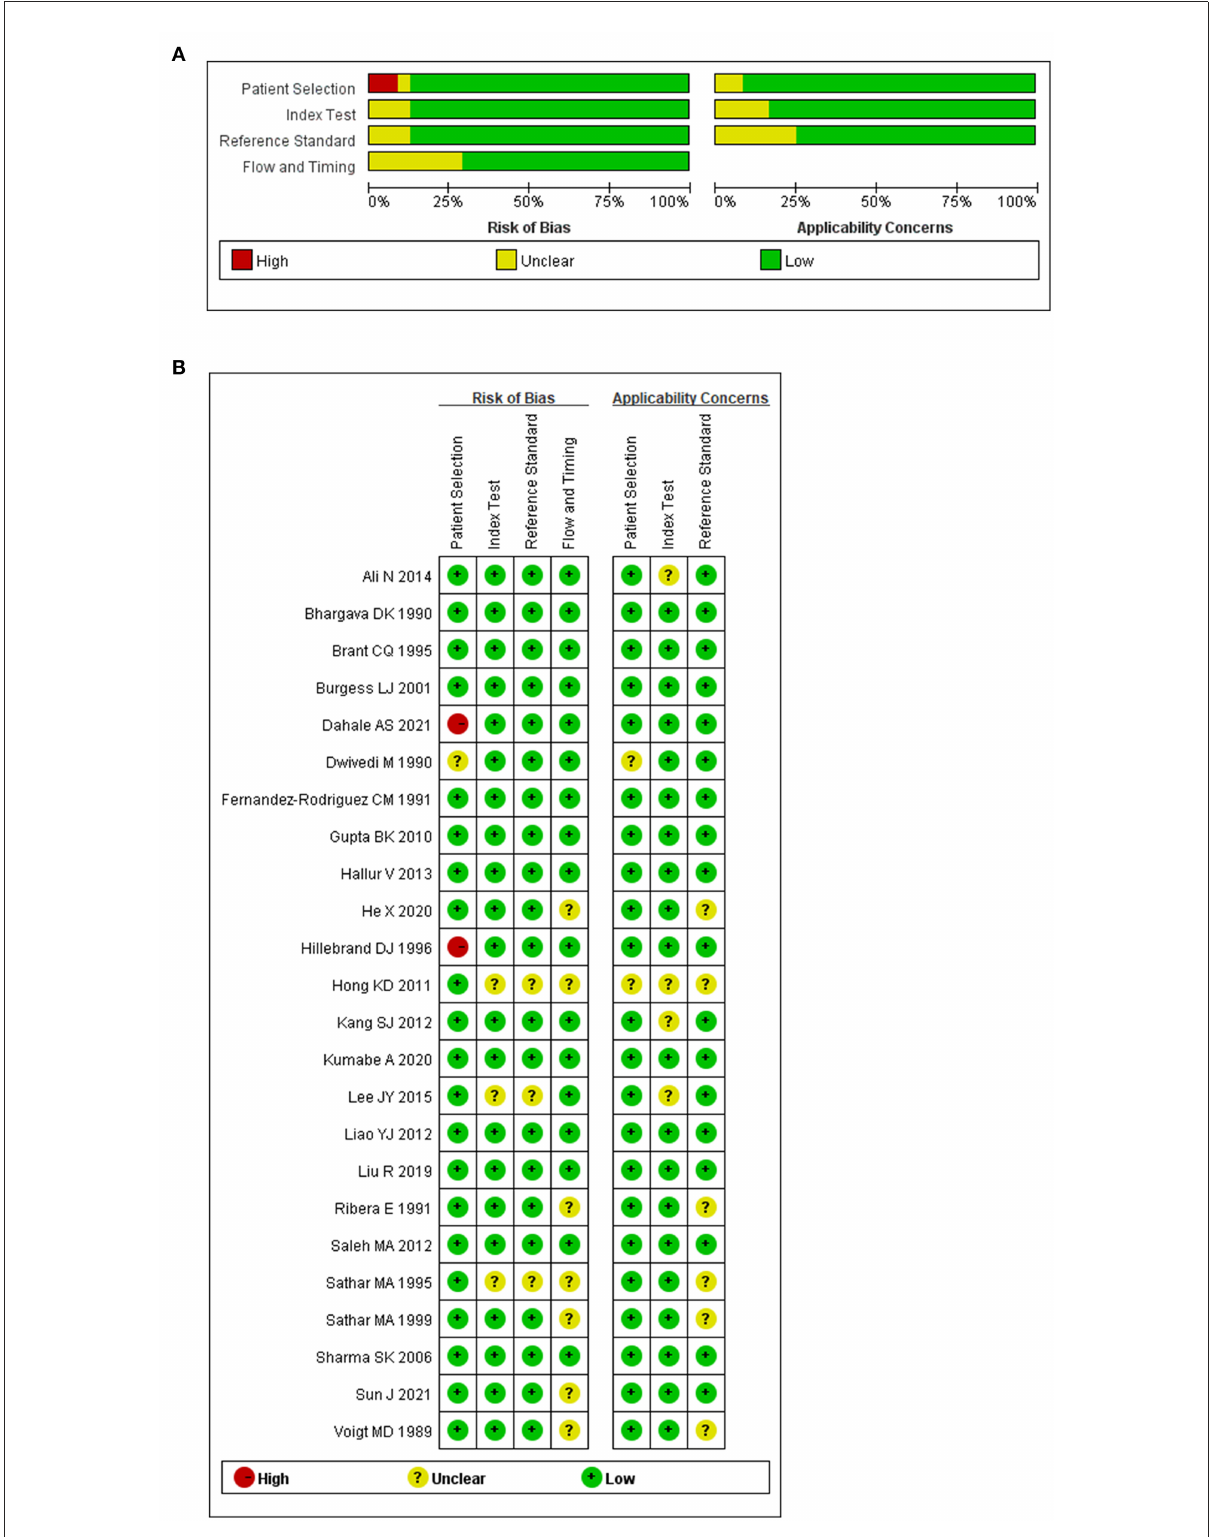
FIGURE2 Methodological quality regarding ADA and abdominal TB. (A) Graph of risk of bias and applicability concerns. (B) Summary of risk bias and applicability